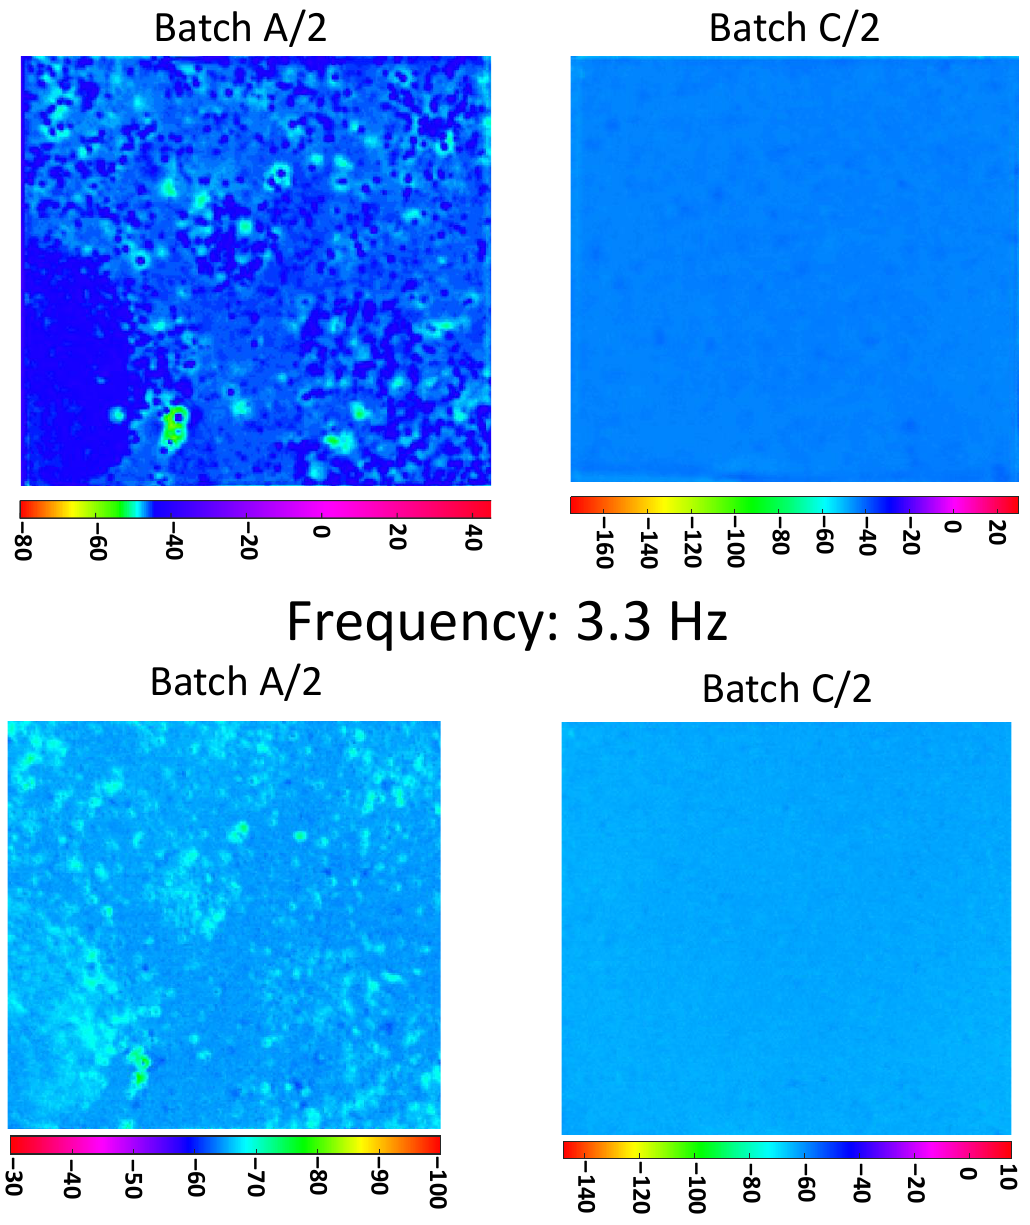
Figure 6. PPT phasegrams comparison of samples coming from A / 2 and C / 2; on the first row phasegrams computed at selected frequency of 0.3 Hz, on the second row phasegrams computed at selected frequency 3.3 Hz.